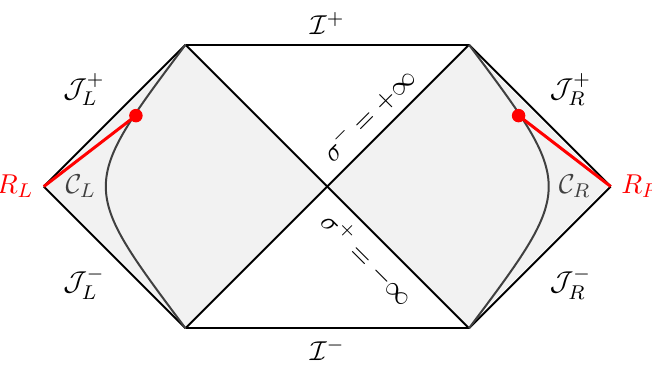
Figure 4 . Penrose diagram of the glued solution where Rindler wedges (shaded gray) replace the static patches of de Sitter space. We define anchor curves C L,R where Φ (cid:29) Φ 0 (cid:29) 1 from which the de Sitter region (white) can be